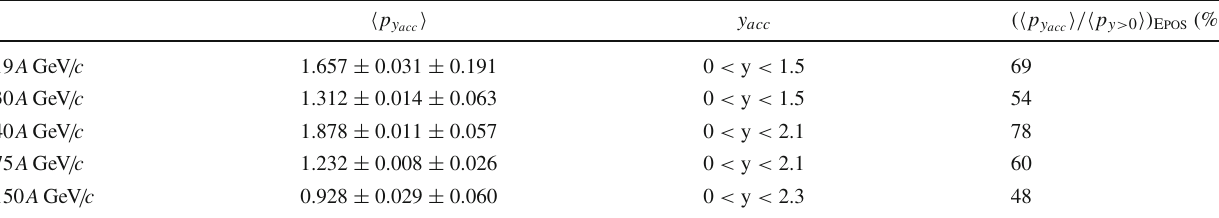
Table 4 Yield of protons in the rapidity acceptance of measurements, the extrapolation factor to mean multiplicity based on the Epos model (cid:4) p y acc